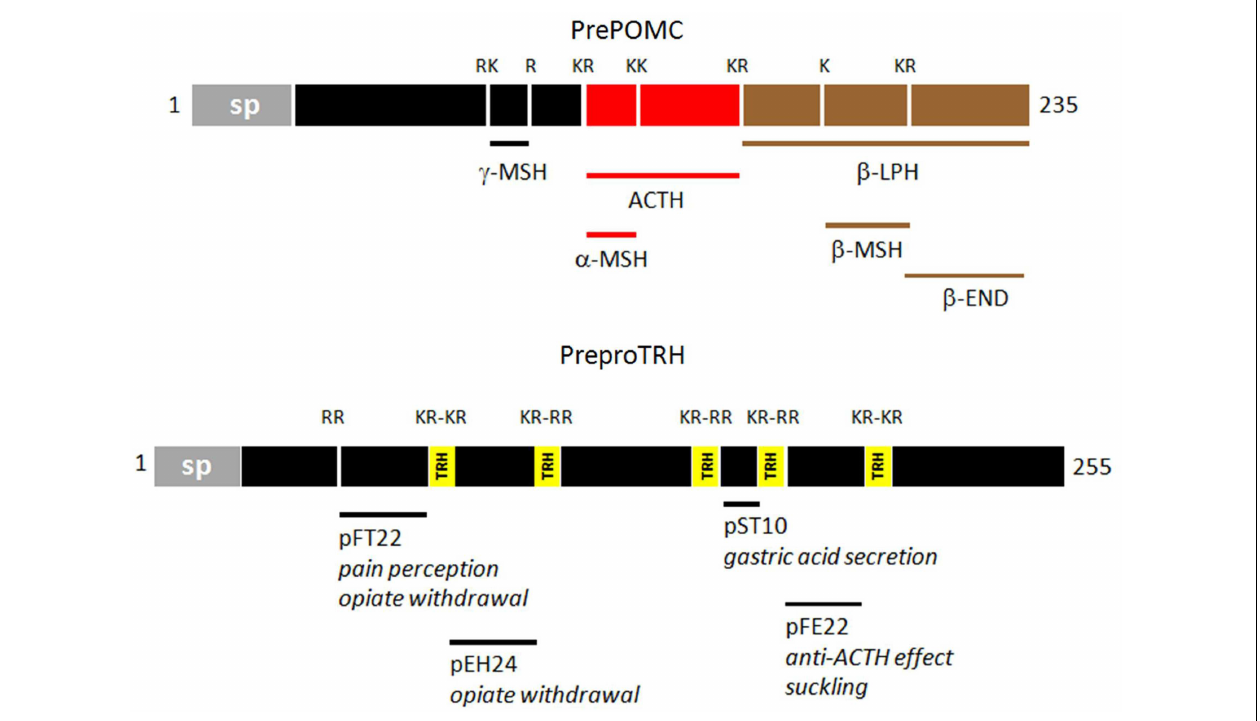
FIGURE 1 | Diagrammatic representations of prePOMC and preproTRH .The diagrams are based on rat sequences.The additional functional peptides of proTRH have been reviewed by Nillni and Sevarino (21). Single and paired basic residues (K/R) flanking the functional peptides are shown. (sp: signal